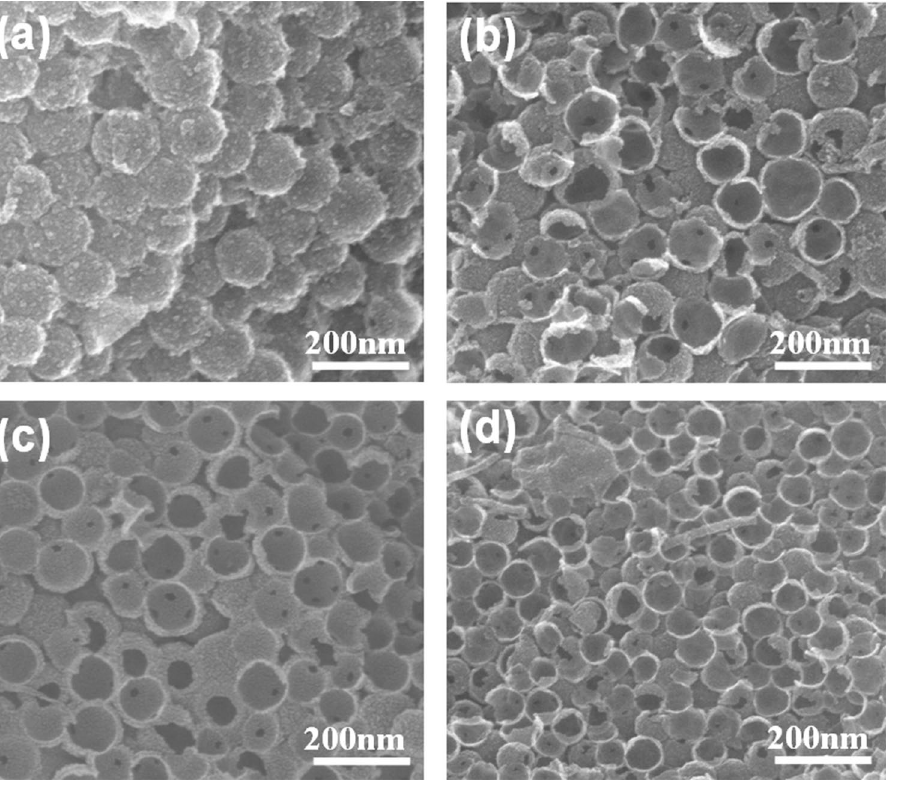
Figure 6. SEM images of HPC prepared from various carbonization temperatures: ( a ) 700 °C, ( b ) 800 °C, ( c ) 900 °C, ( d ) 1000